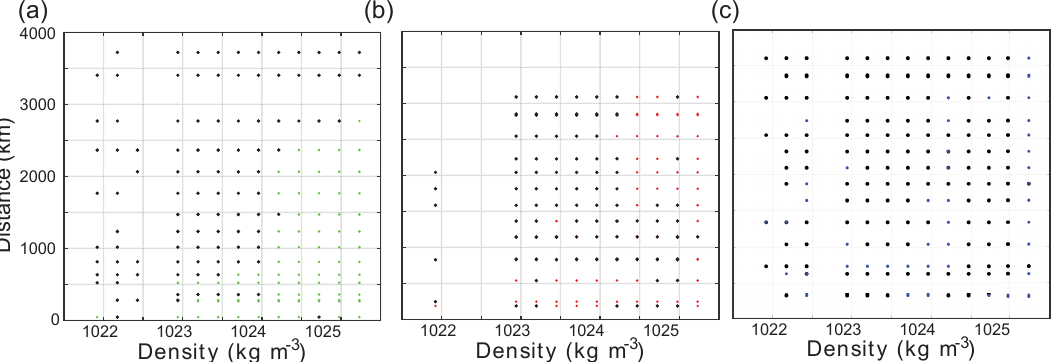
Figure 13. SD station Z -score over distance for (a) LDA, (b) LDB, and (c) LDC. | Z | > 2 shaded black. Rossby radii R D distance plotted in horizontal lines, color coded to the LD